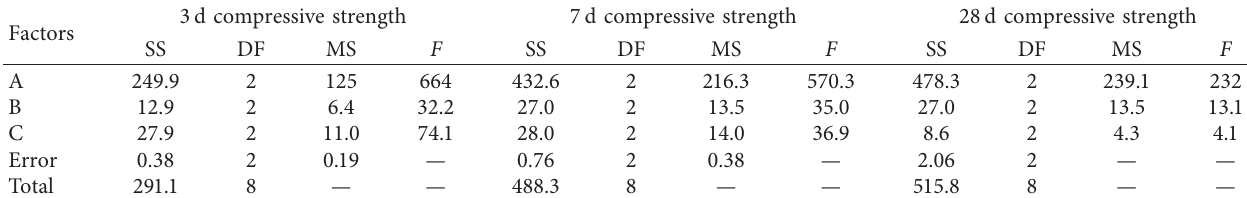
Table 6: Results of the variance analysis based on compressive strength.